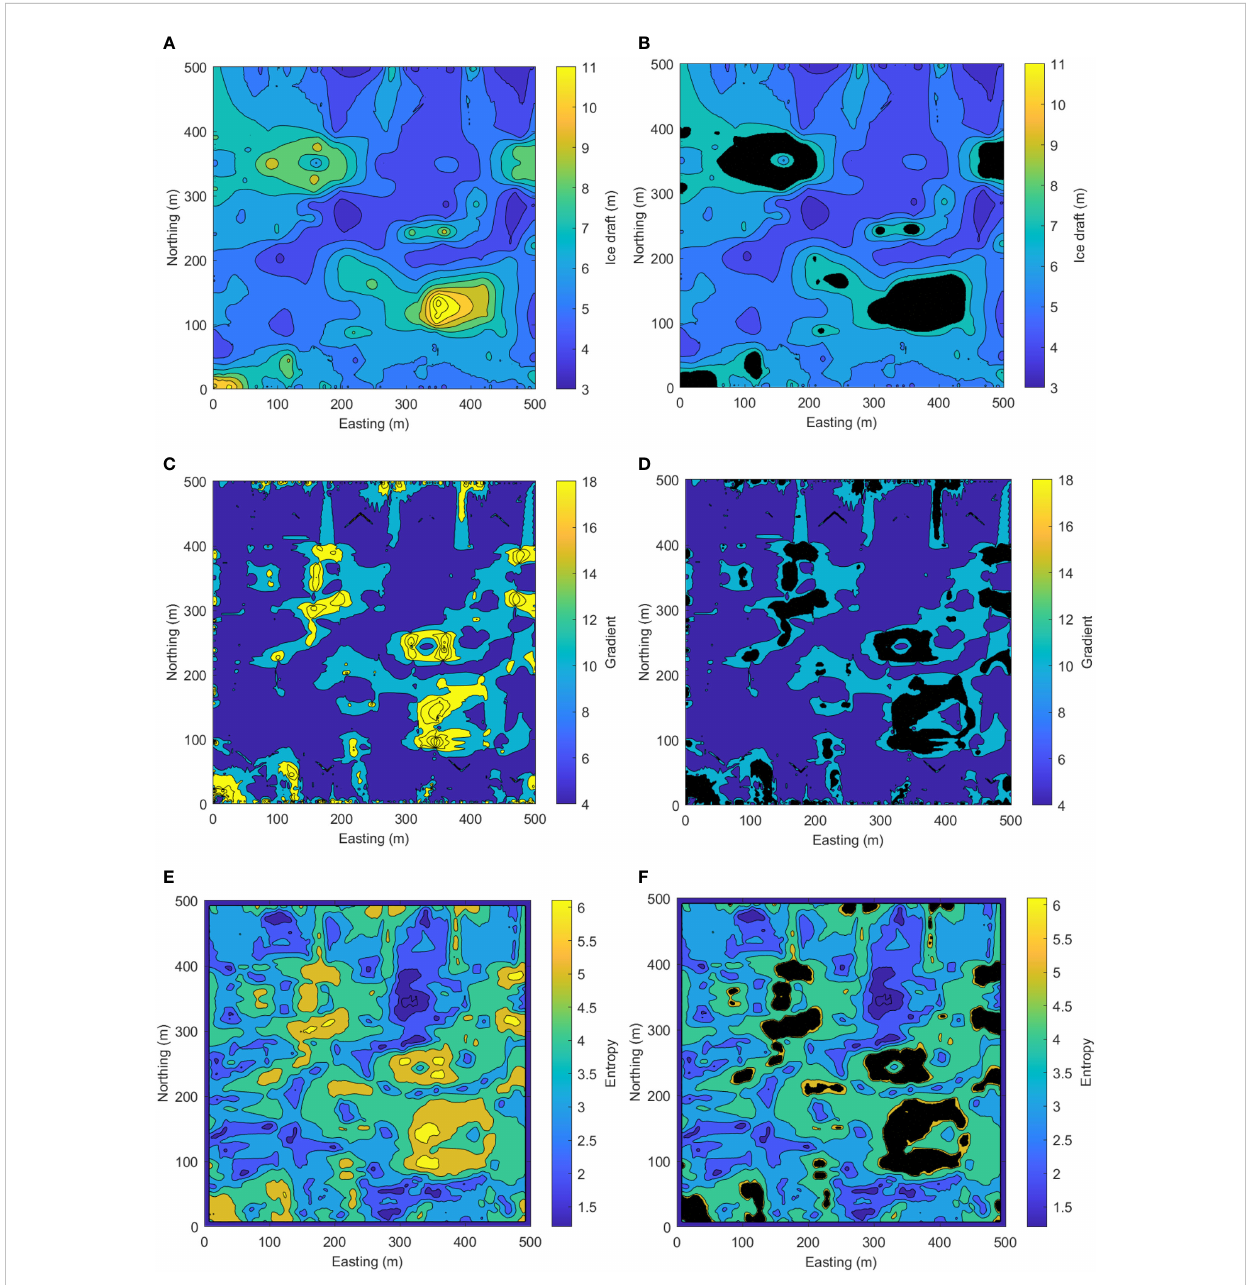
FIGURE 6 Roughly reconstructed ice draft results and interested regions identi fi ed by different criteria. (A) Rough reconstruction of ice draft map. (B) Interested regions identi fi ed by ice draft criterion. (C) Ice draft gradient of the roughly reconstructed map. (D) Interested regions identi fi ed by ice draft gradient criterion. (E) Ice draft entropy of the roughly reconstructed map. (F) Interested regions identi fi ed by ice draft entropy